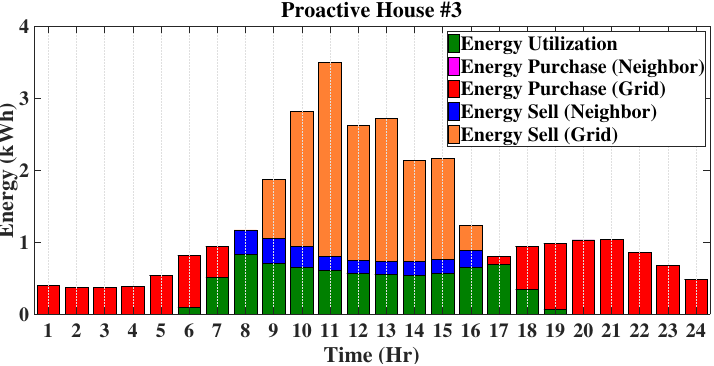
Figure 15. Energy profiles of Proactive House #3 on a typical summer day.